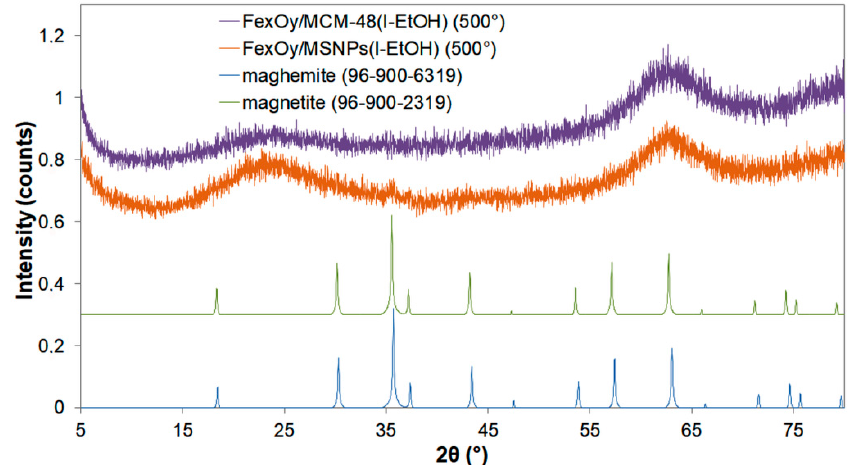
Figure 2. XRD diffractograms of the Fe x O y /MCM-48 and the Fe x O y /MNPs materials obtained by dry impregnation and reduced at 500 °C (bump at 2 θ = 63–64° is an artefact due to the sample holder) with reference data for magnetite and maghemite phases.